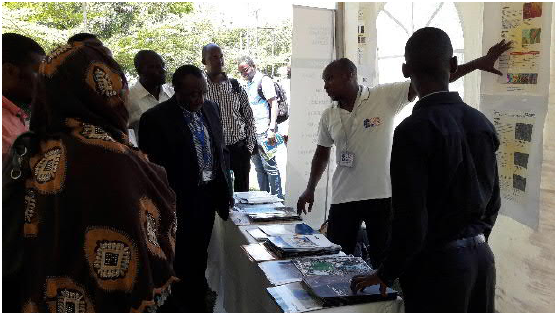
Figure 9. In the GIS Day, geospatial experts, companies and institutions were presenting their ongoing activities and projects in Tanzania (November 2017).